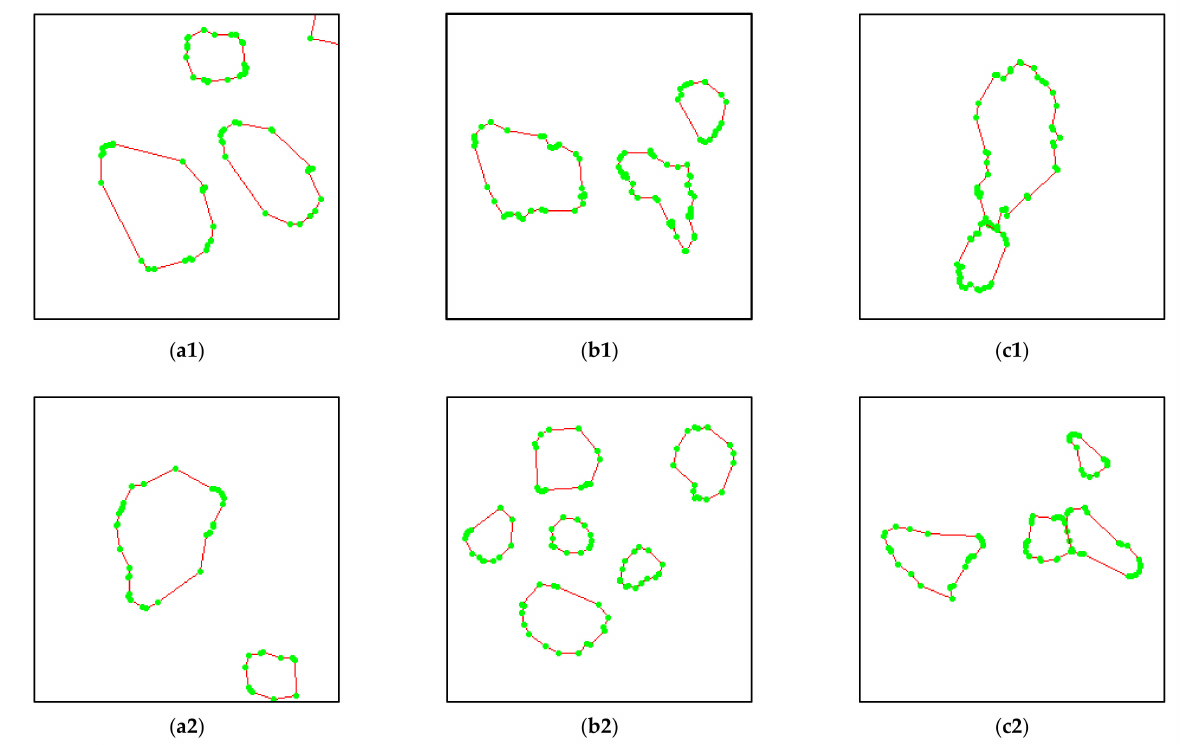
Figure 14. Experimental results of remote sensing images: ( a1 ) Island image 1; ( b1 ) Island image 2; ( c1 ) Island image 3; ( a2 ) Lake image 1; ( b2 ) Lake image 2; ( c2 ) Lake image 3.